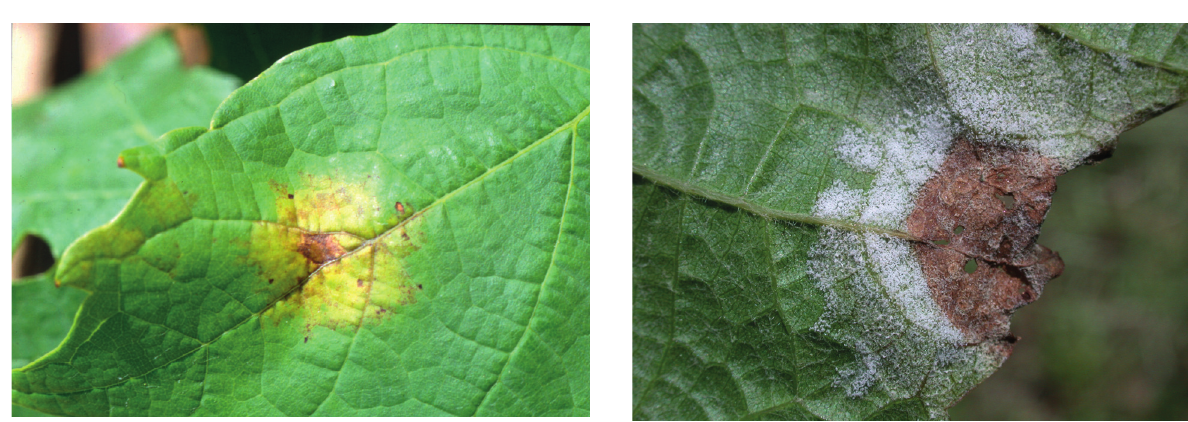
Figure 3. old oilspot with necrosis on the adaxial leaf surface.